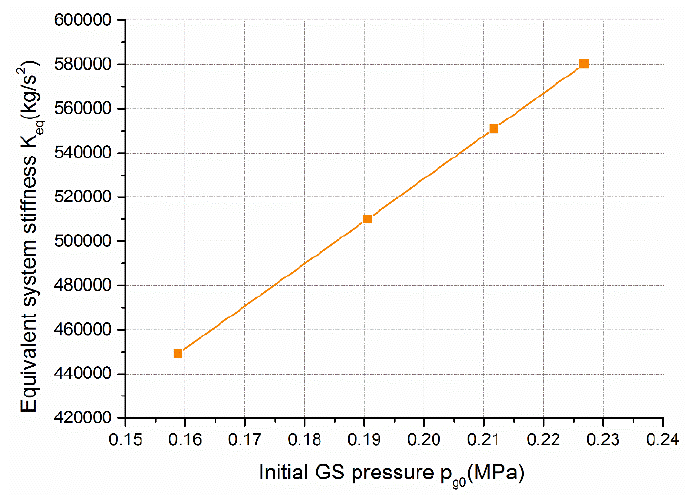
Figure 9. The equivalent system stiffness versus initial GS pressure.